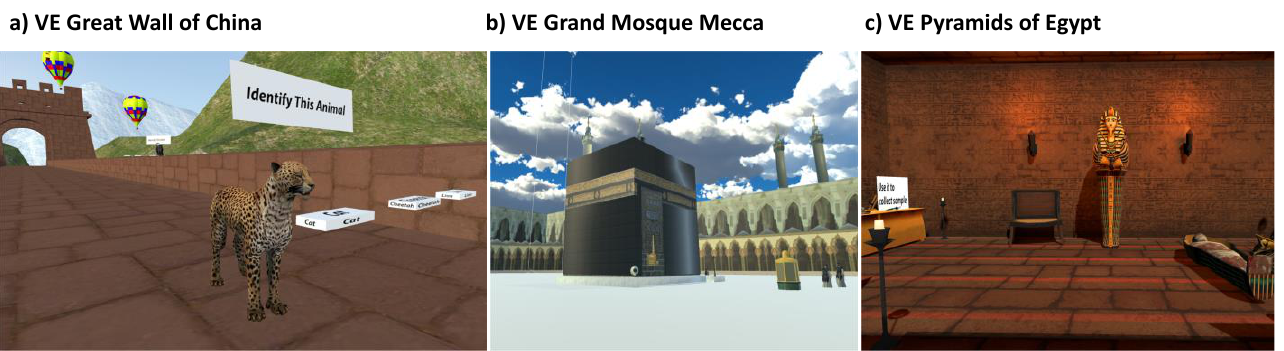
Figure 1. Representation of different virtual environments with examples of environmental enrichment exercises incorpo- rated.